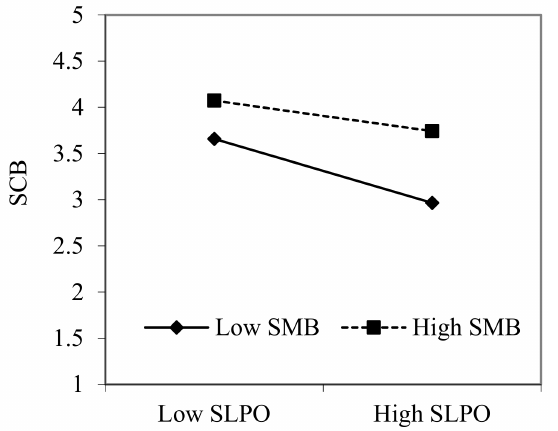
Figure 3. The interaction effect of SLPO and SMB on SCB. Note: SLRO, safety-specific leader reward omission, SLPO, safety-specific leader punishment omission, SMB, safety moral beliefs and SCB, safety compliance